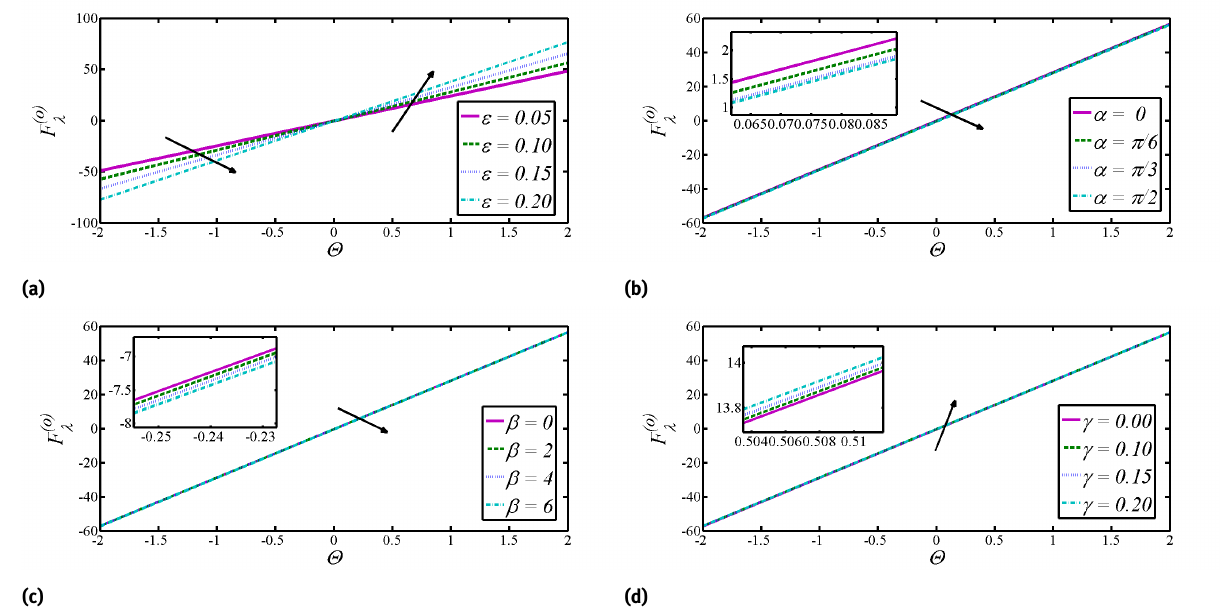
Fig. 6: The frictional forces on the outer tube verses volume flow rate for various fluid